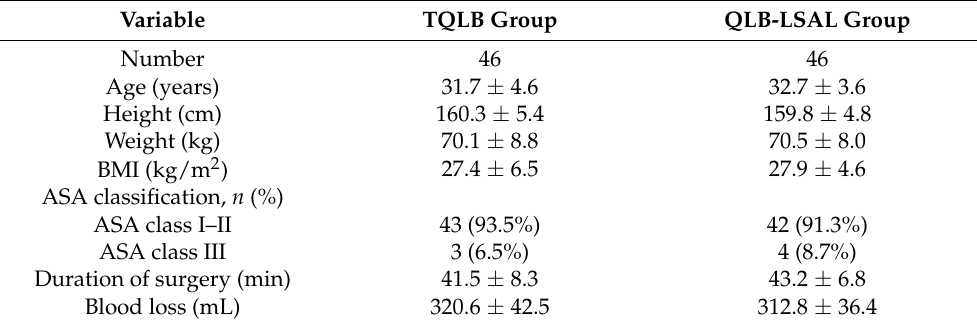
Table 1. Demographic and clinical characteristics.